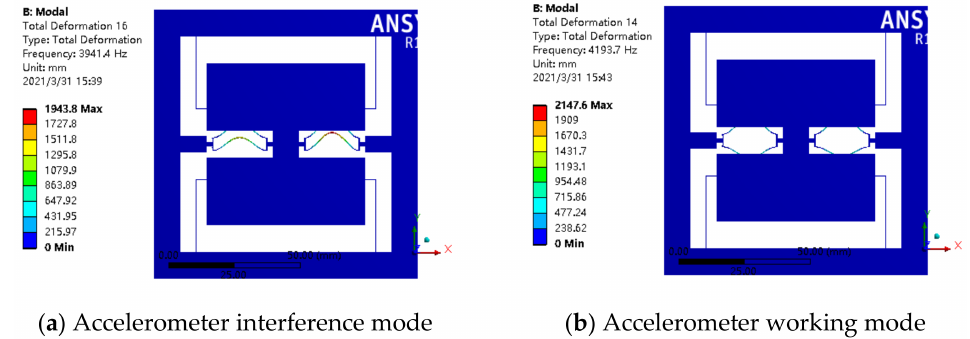
Figure 16. Mode analysis of accelerometer: ( a ) interference mode; ( b ) working mode.